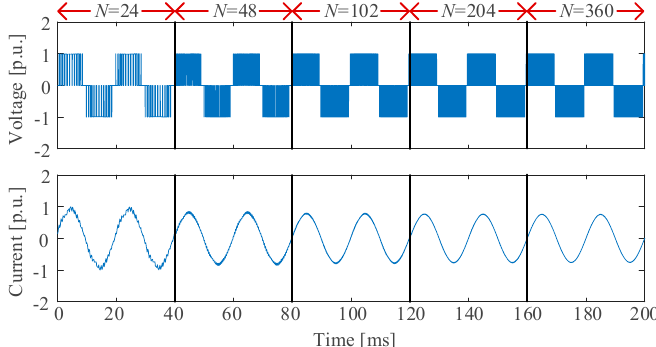
Figure 7. Simulated results in steady-state for different sampling times.